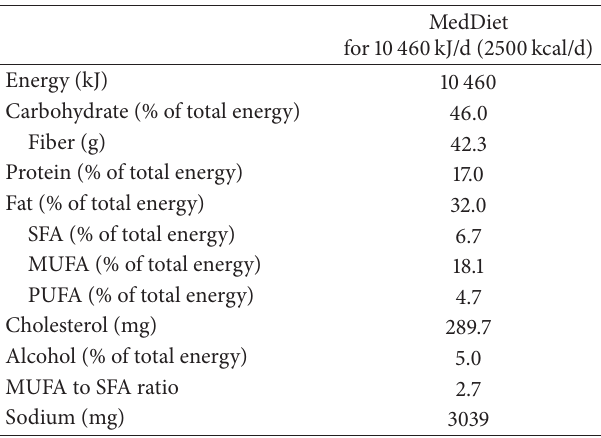
Table2:DailynutritionalcompositionoftheexperimentalMediter- ranean diet for a 10460 kJ/d (2500 kcal/d)